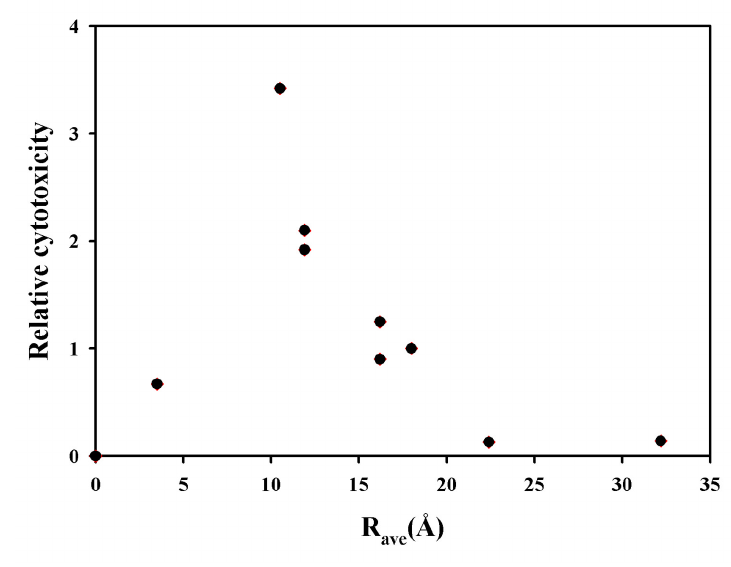
FIGURE 5 . Relation between relative biological activity and calculated R ave